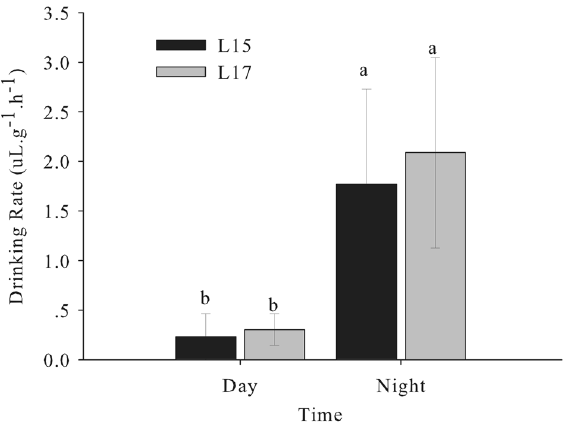
Figure 1. Drinking rates of Gymnocypris przewalskii exposed to saline-alkaline lake water (L15 and L17) at different times (Day 10:00–16:00, Night 22:00–4:00) (n = 9 per treatment). Light–dark cycle was 14:10-h light:dark (5:00–19:00 with light intensity of 600–1000 lx;19:00–5:00 with light intensity of 0 lx); L15 and L17 refers to saline-alkaline lake water with a salinity of 15 or 17. Lowercase indicates significantly difference among time points in each treatment ( P < 0.05).